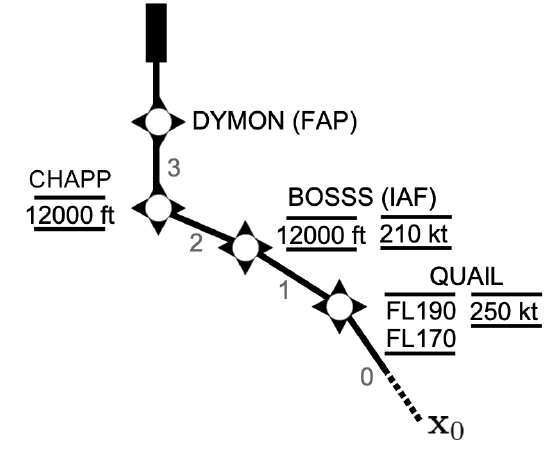
Figure 1. BOSSS TWO standard arrival procedure. Table 1. Definition of the phases and associated constraints for the BOSSS TWO